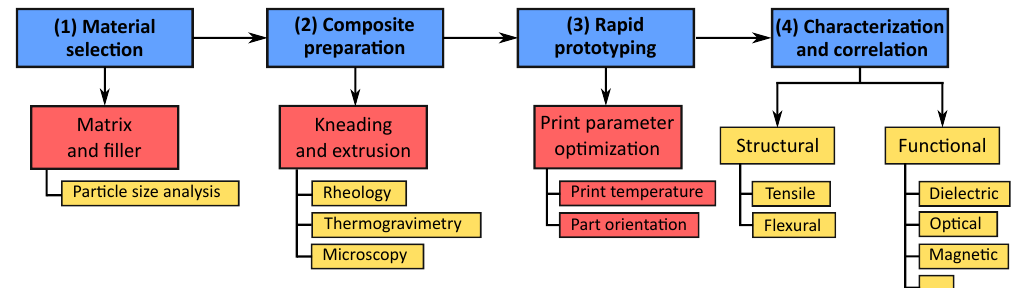
Figure 1. A schematic describing the various phases in the preparation, structuring and characterization of polymer-based composites using ARP. Blue: The four phases in the process, starting with (1) the selection of appropriate constituent materials, followed by (2) the preparation of the composite, through (3) 3D printing to (4) the characterization of the printed samples and correlation with existing data or a theoretical model. Red: The process steps used in this work for the ABS-BT composites. Yellow: The corresponding characterization for each of the process steps including investigations into the material, structural and functional properties of the